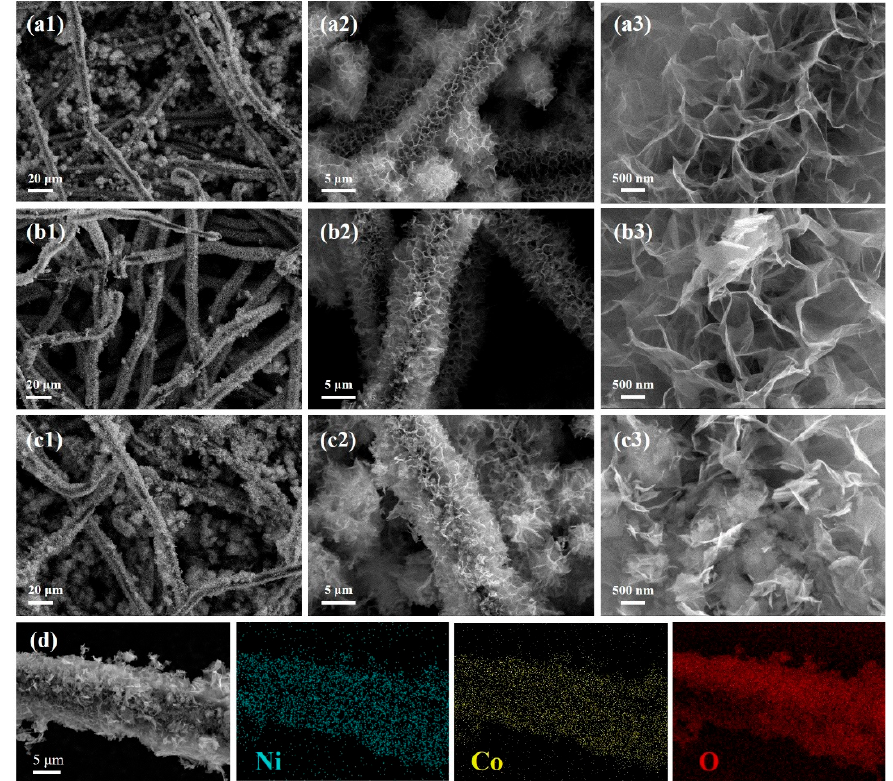
Figure 3. SEM images of the ( a1 – a3 ) NCO NSs/BCFs-6h; ( b1 – b3 ) NCO NSs/BCFs-8h; ( c1 – c3 ) NCO NSs/BCFs-10h; ( d ) EDS elemental mapping of Ni, Co, and O for NCO NSs/BCFs-10h. NSs / BCFs-10h; ( d ) EDS elemental mapping of Ni, Co, and O for NCO NSs /